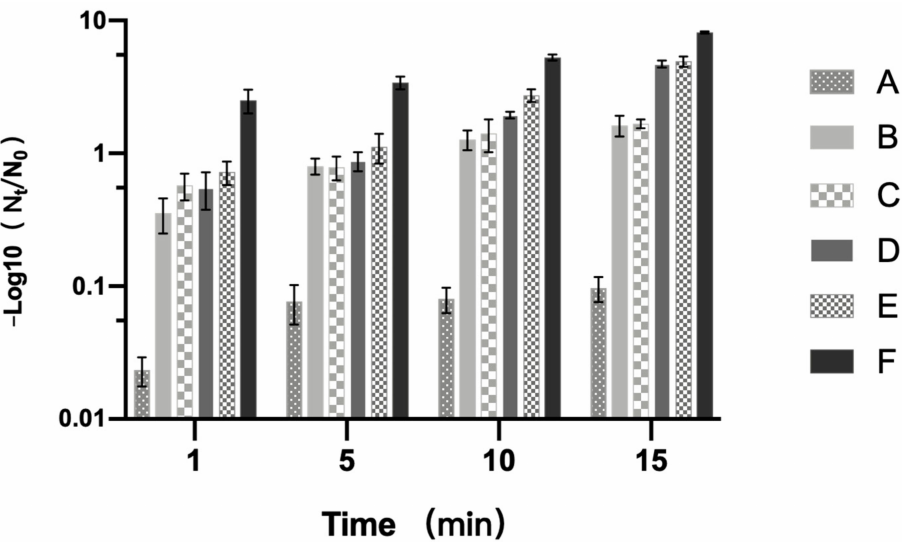
Figure 2. Effects of different concentrations of LK combined with PT on spore inactivation. ( A ) Un- treated; ( B – F ) treated at 200 MPa and 80 ◦ C combined with LK at concentrations of 0, 10 − 2 , 1, 10, and 10 2 µ g/mL,